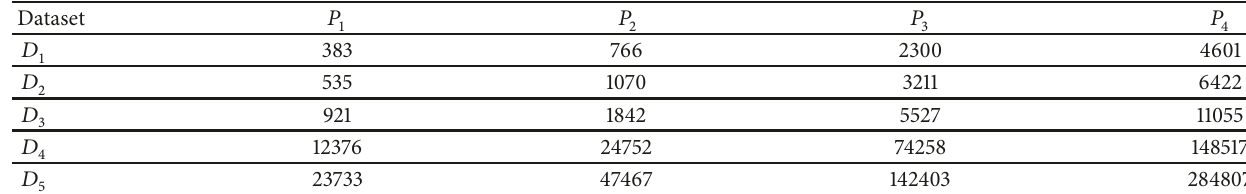
Table 3: Description of the partitions of the set of datasets D